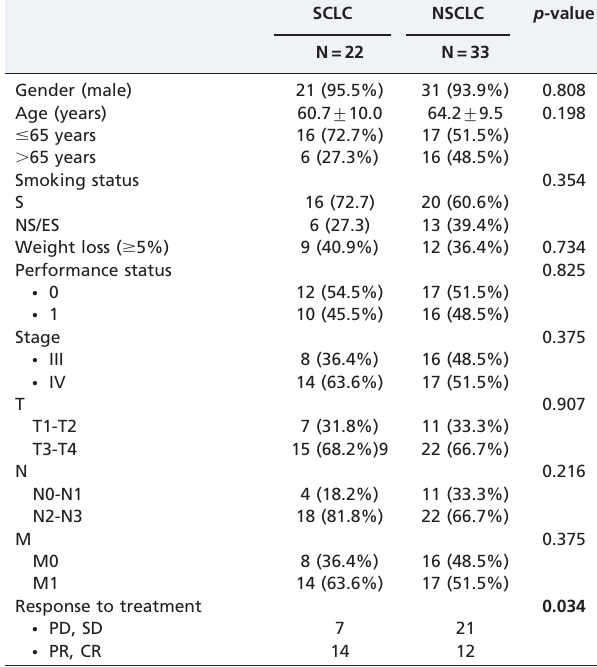
Table 1 - Characteristics and response to treatment of patients with SCLC and